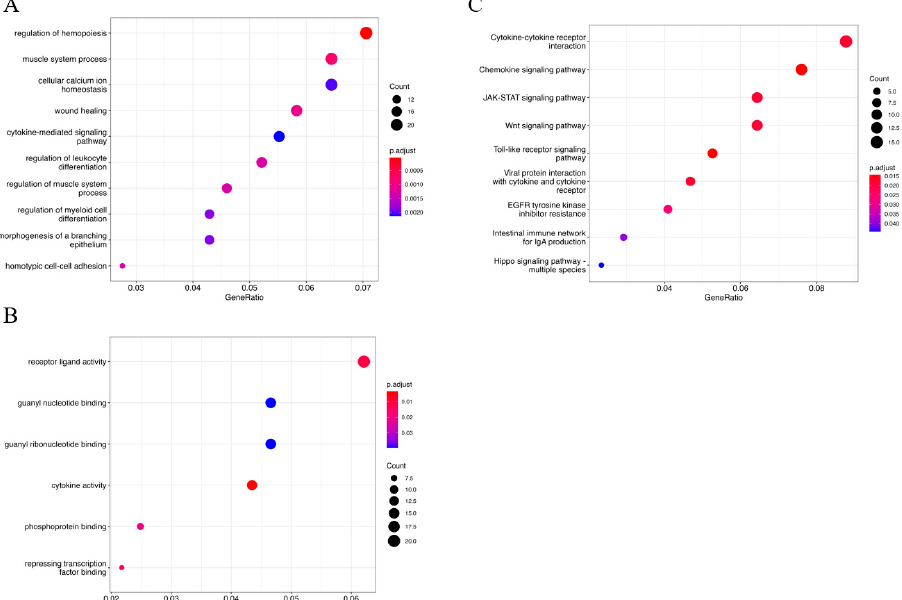
Figure 3. Function enrichment of the genes in the yellow module. The size of the nodes denotes the number of selected genes in pathway or biological processes and the color of the nodes refers to the significance of the results. ( A ) GO-BP (biological processes); ( B ) GO-MF (molecular function); ( C ) KEGG pathway.